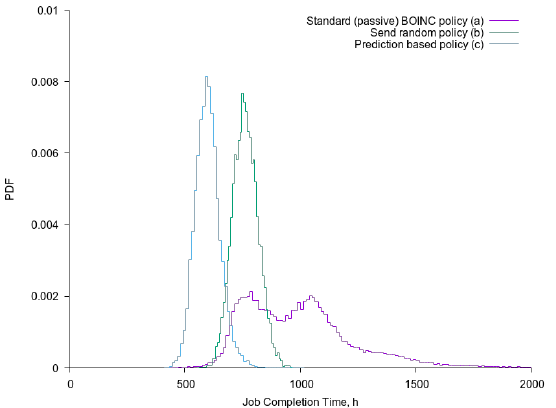
Figure 5: BoT completion time distributions: 5-th cluster, T =168h, d =336h. The standard BOINC (a), random (b) and the Eq. 4 (c) policies are